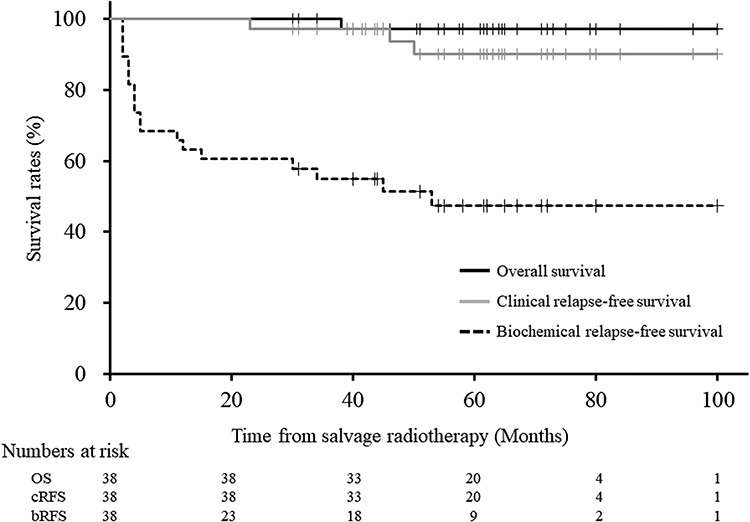
Kaplan–Meier curves for overall, clinical recurrence-free and biochemical recurrence-free survival rates after hypofractionated salvage radiotherapy in patients with biochemical recurrence of prostate cancer after radical prostatectomy.